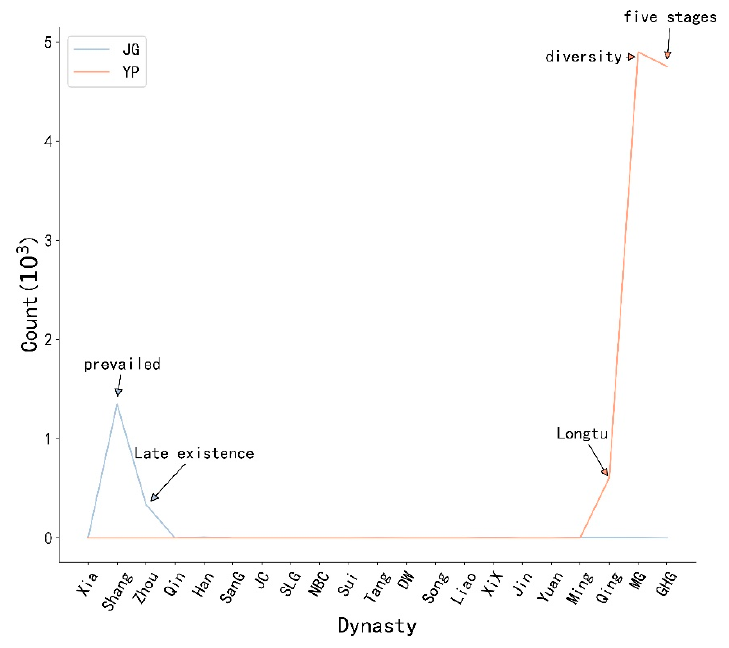
Figure 3. “Life cycle” of bones and stamp products.